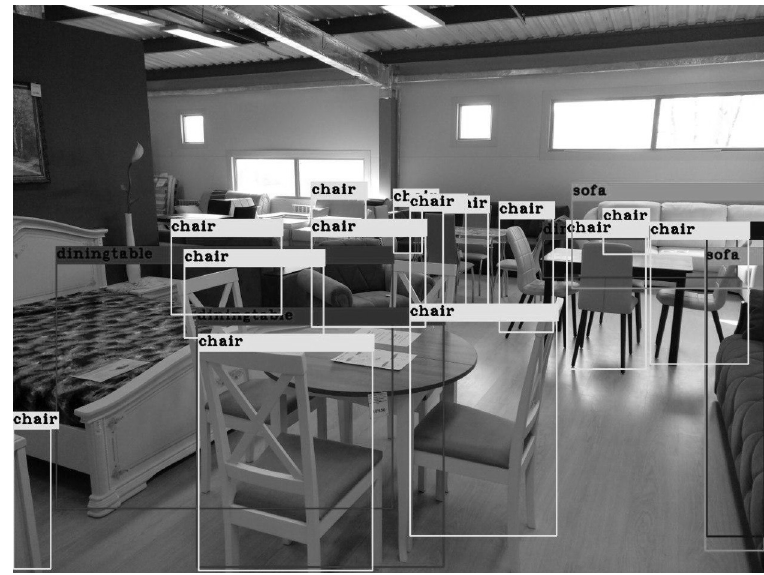
Figure 1. An instance of YOLOv3 detection on sample